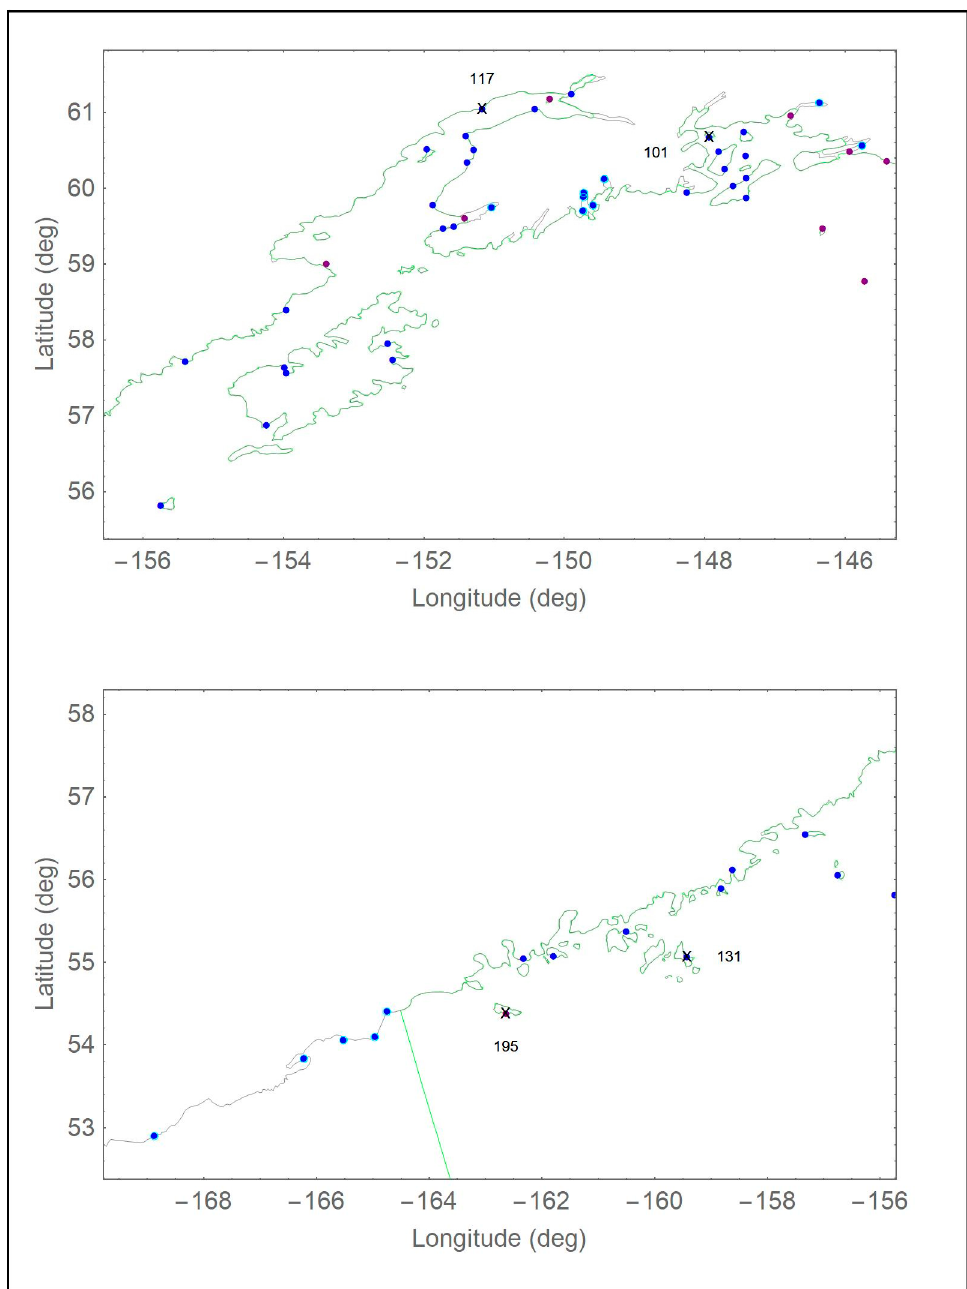
Figure A5. Location of validation stations: South Alaska.